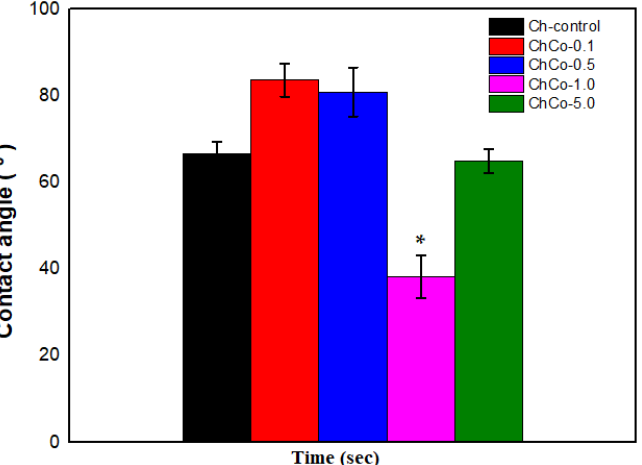
Figure 5. Contact angle of membranes with analysis of the Anova Test ( p < 0.05; DF = 4) and the Tukey Test. The asterisk indicates the sample with significant statistical difference ( p < 0.05).